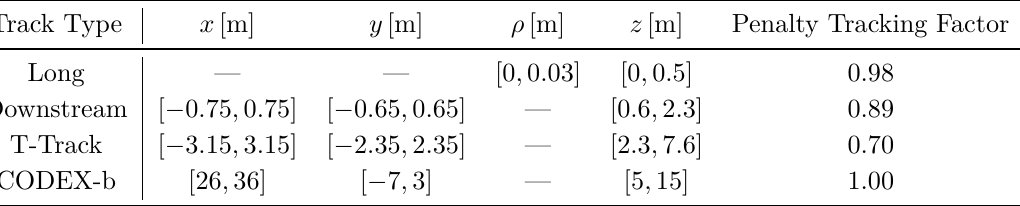
Table 1 . Different track types at the LHCb and CODEX-b experiments that are studied in this work and the corresponding geometrical requirements [33, 36, 37]. The track reconstruction efficiencies are estimated according to refs. [38–40]. For CODEX-b no penalty for the track reconstruction can be estimated